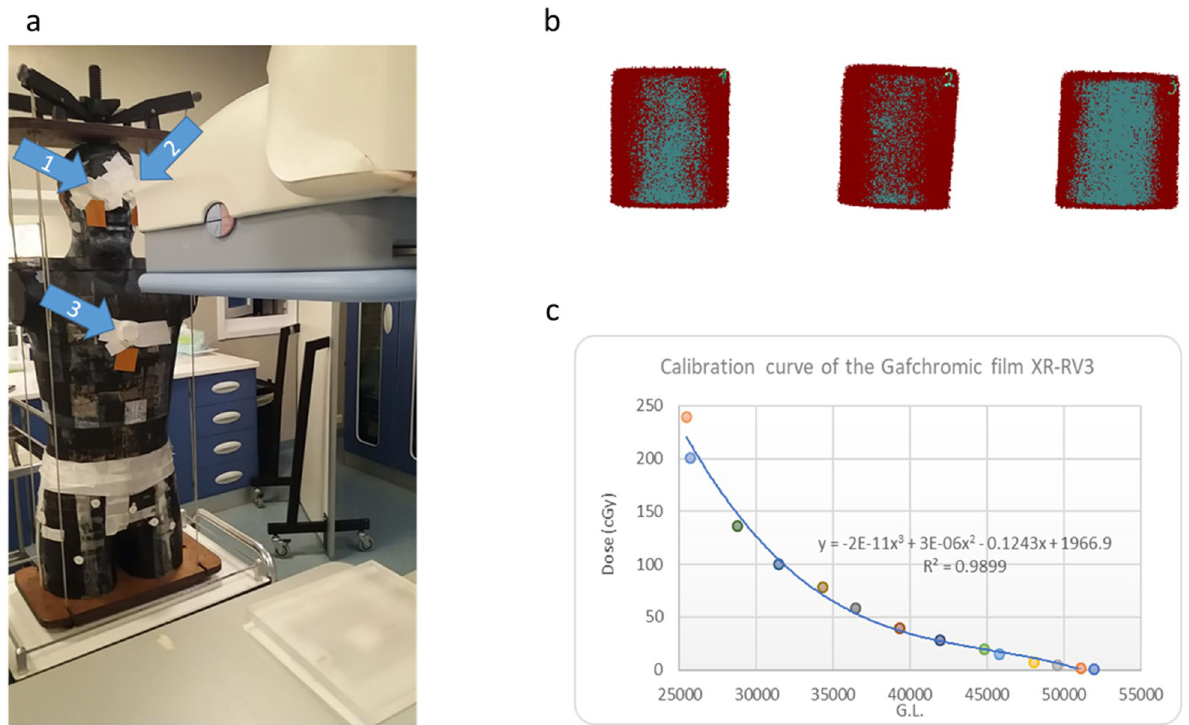
Figure 1. ( a ) experimental setup, ( b ) example of dose map measured using the Gafchromic films XR-RV3 and ( c ) used calibration